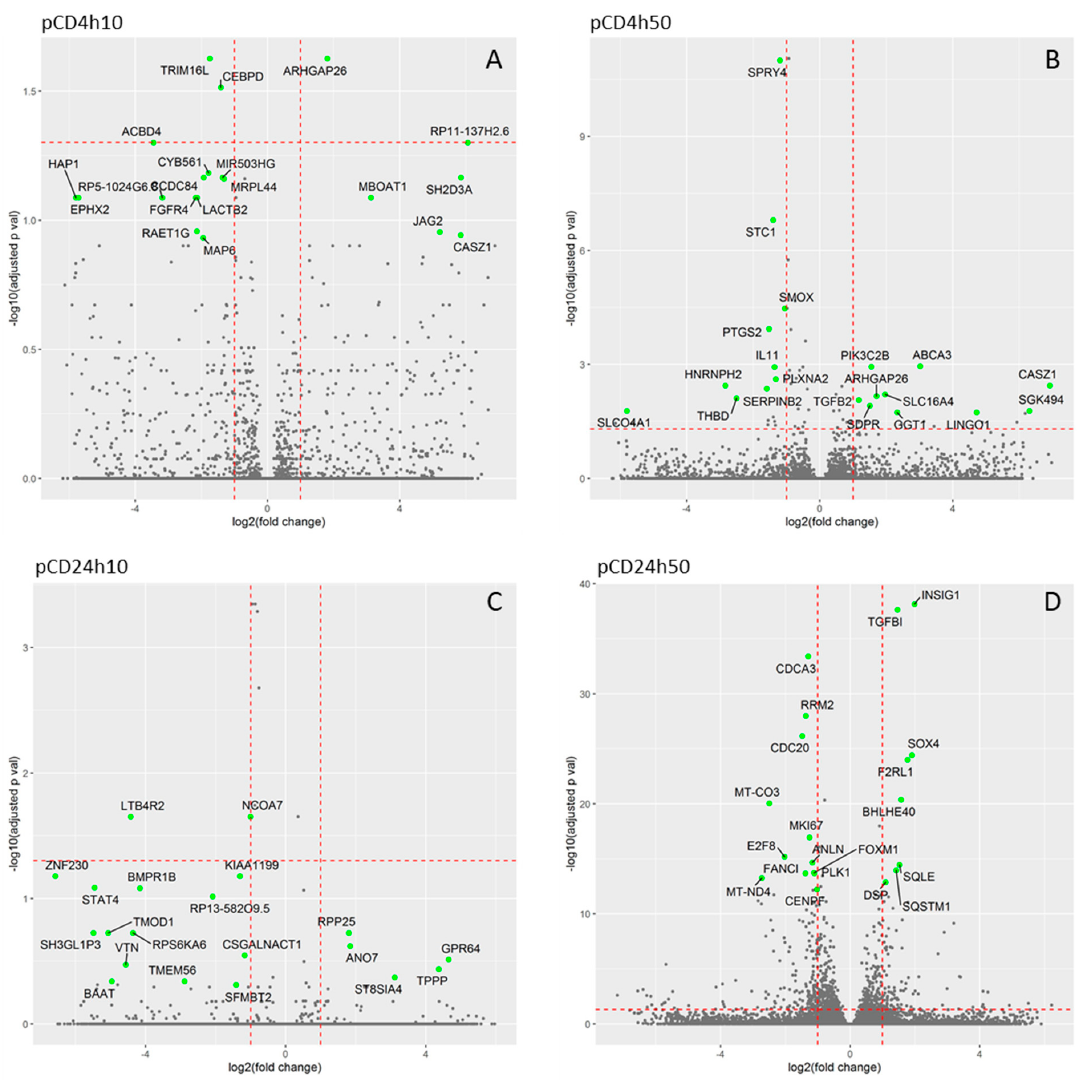
Figure 5. Volcano scatter-plots showing the relationship between significance and fold change of individual mRNA transcripts expression. The horizontal dashed red line highlights the adjusted p -value of 0.05, the vertical lines denote the fold changes equal of 0.5 and 2. In each plot the 20 most significant transcripts are identified. ( A )- pCD4h10, ( B )- pCD4h50, ( C )- pCD24h10, ( D )- pCD24h50.